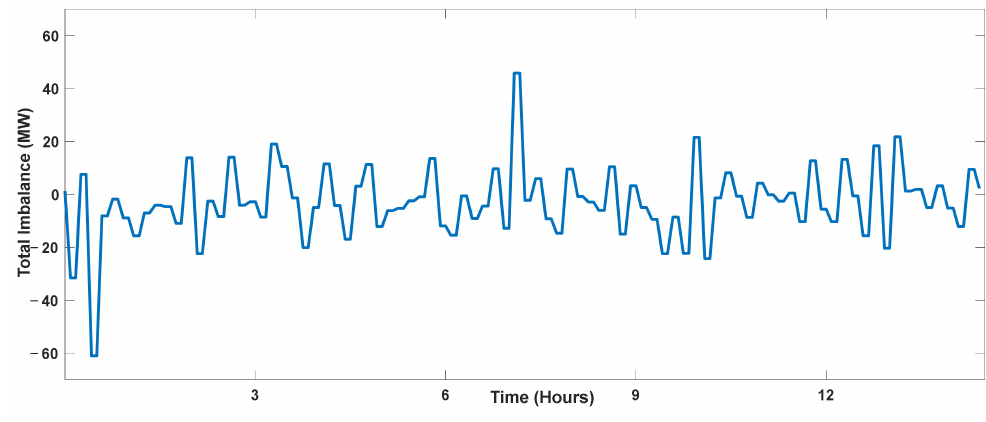
Figure 16. Total Imbalance.